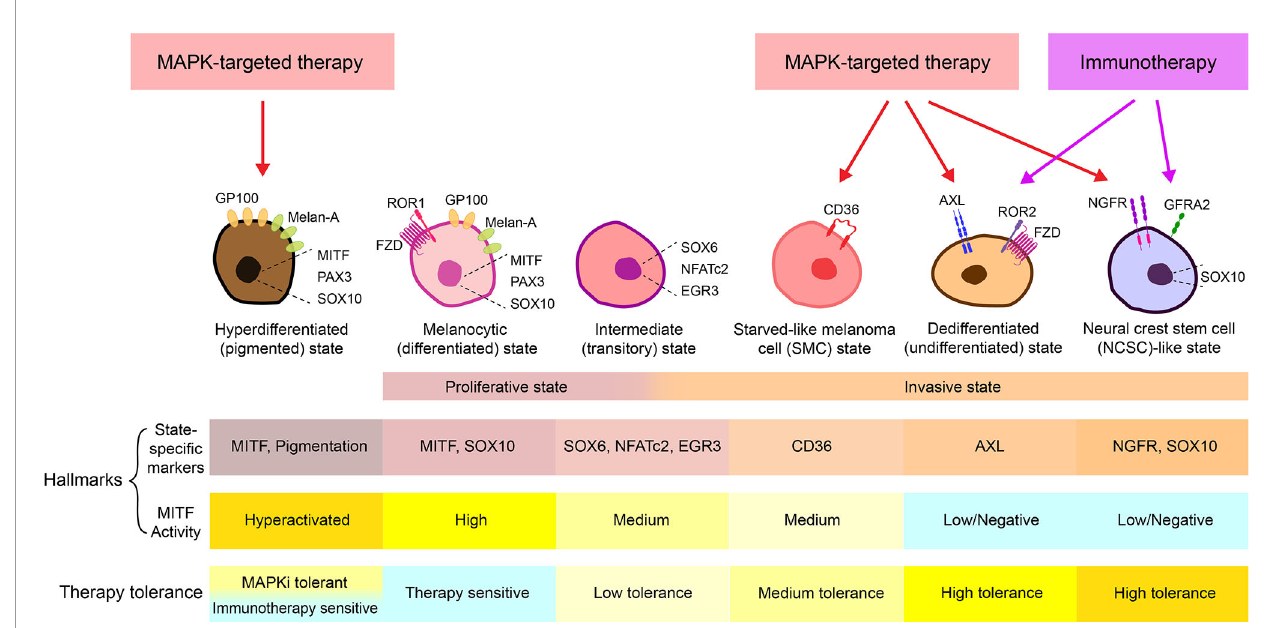
FIGURE 1 | Melanoma cell states. At least 6 different melanoma cell states have been thus far characterized, including a MAPKi-induced hyperdifferentiated/ pigmented state, a MITF high /AXL low melanocytic/differentiated state, an intermediate/transitory state, a CD36 + starved-like melanoma cell (SMC) state, a MITF low / AXL high dedifferentiated/undifferentiated state, and a MITF low /NGFR high neural crest stem cell (NCSC)-like state (3, 13 – 16). While the hyperdifferentiated state is induced by MAPK-targeted therapy and the intermediate state exhibit both proliferative and invasive phenotypes, the melanocytic state generally corresponds to the “ proliferative ” state, and the SMC state, the dedifferentiated state, and the NCSC-like state together make up the “ invasive ” state (14 – 16). Notably, in many cases, an “ invasive ” phenotype is used to describe the MITF low /AXL high dedifferentiated population, while in some other cases, the “ invasive ” state refers to both AXL high / dedifferentiated and NGFR high /dedifferentiated populations. To avoid confusion, cell state-speci fi c markers and MITF activity are often combined to de fi ne each state. For example, it is generally accepted that the melanocyte state is marked as MITF high /AXL low , the SMC state is marked with CD36 + and medium activity of MITF, the dedifferentiated state is de fi ned as MITF low /AXL high and the NCSC-like state is de fi ned as MITF low /NGFR high /SOX10 + /GFRA2 + (3, 13 –